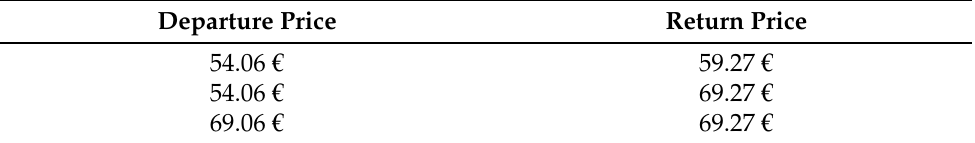
Figure 4. Lufthansa prices acquired near departure. Table 5. Price pairs of Lufthansa